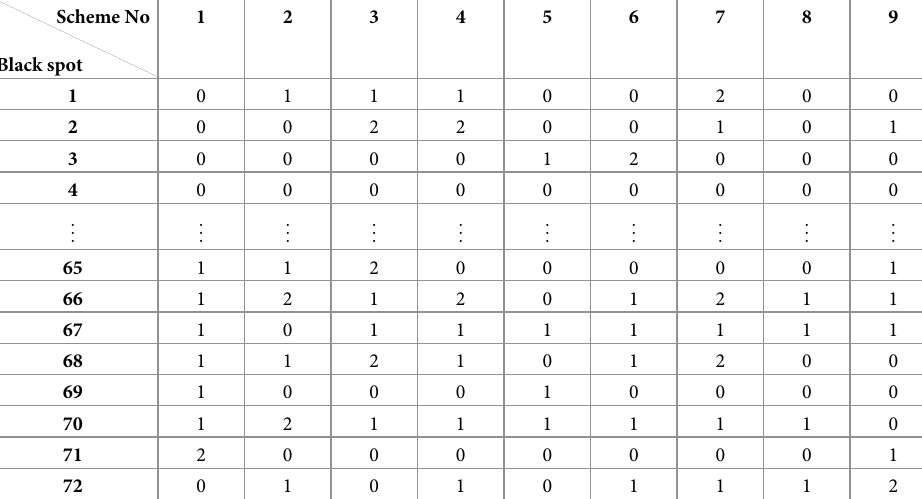
Table 6. The initial alternative plans by SP model. Scheme No Black